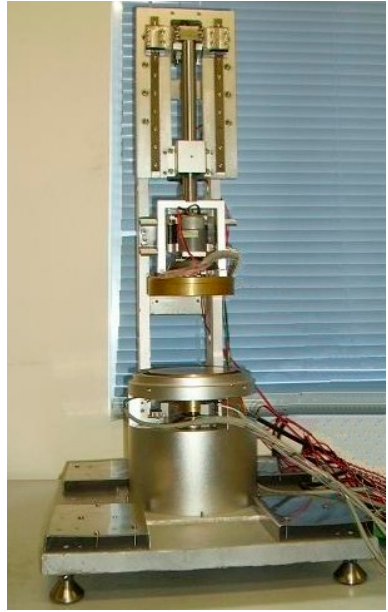
Figure 10. Mechanical equipment prototype of the measurement system.